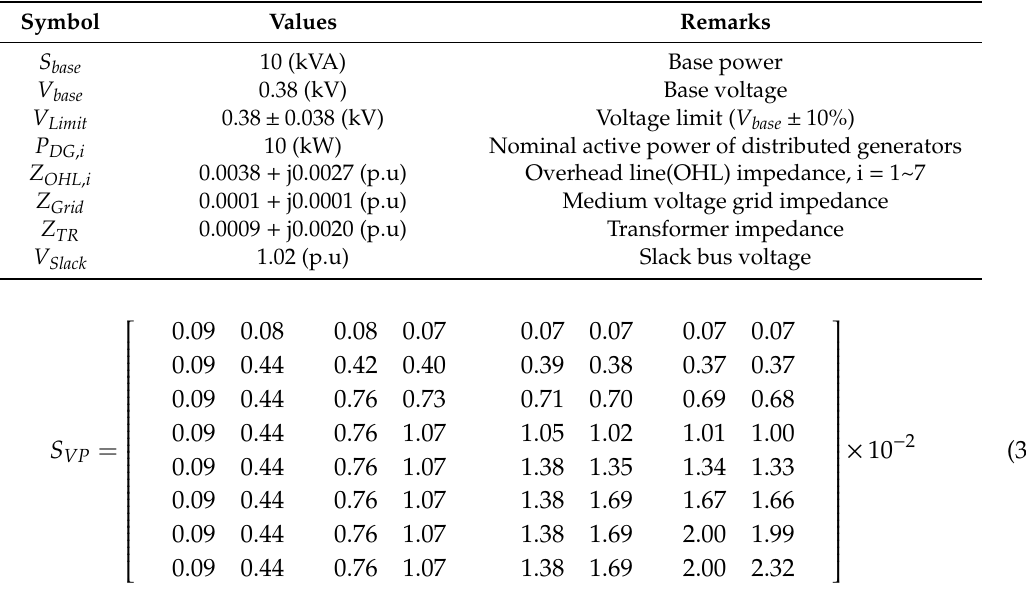
Figure 1. Test feeder model for reactive power control evaluation. Table 1. Parameters of test feeder model.